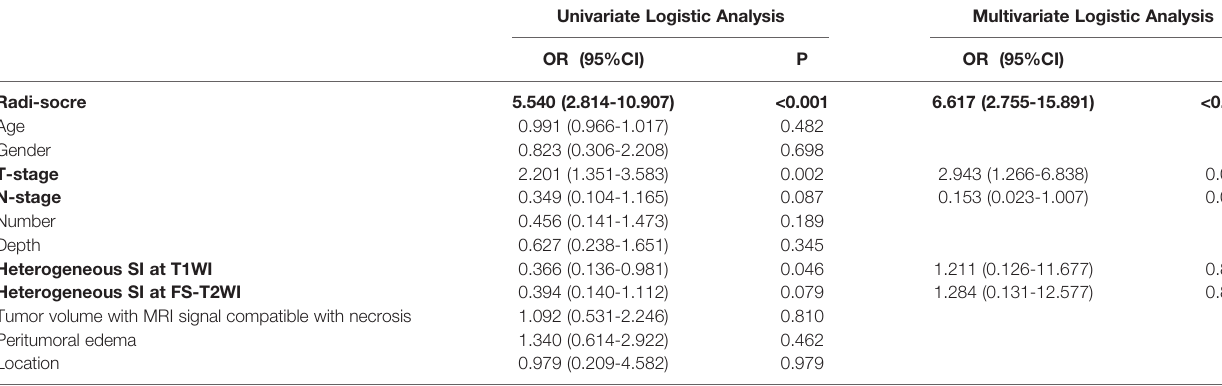
TABLE 2 | Results of univariate and multivariate logistic regression analysis in soft-tissue sarcoma